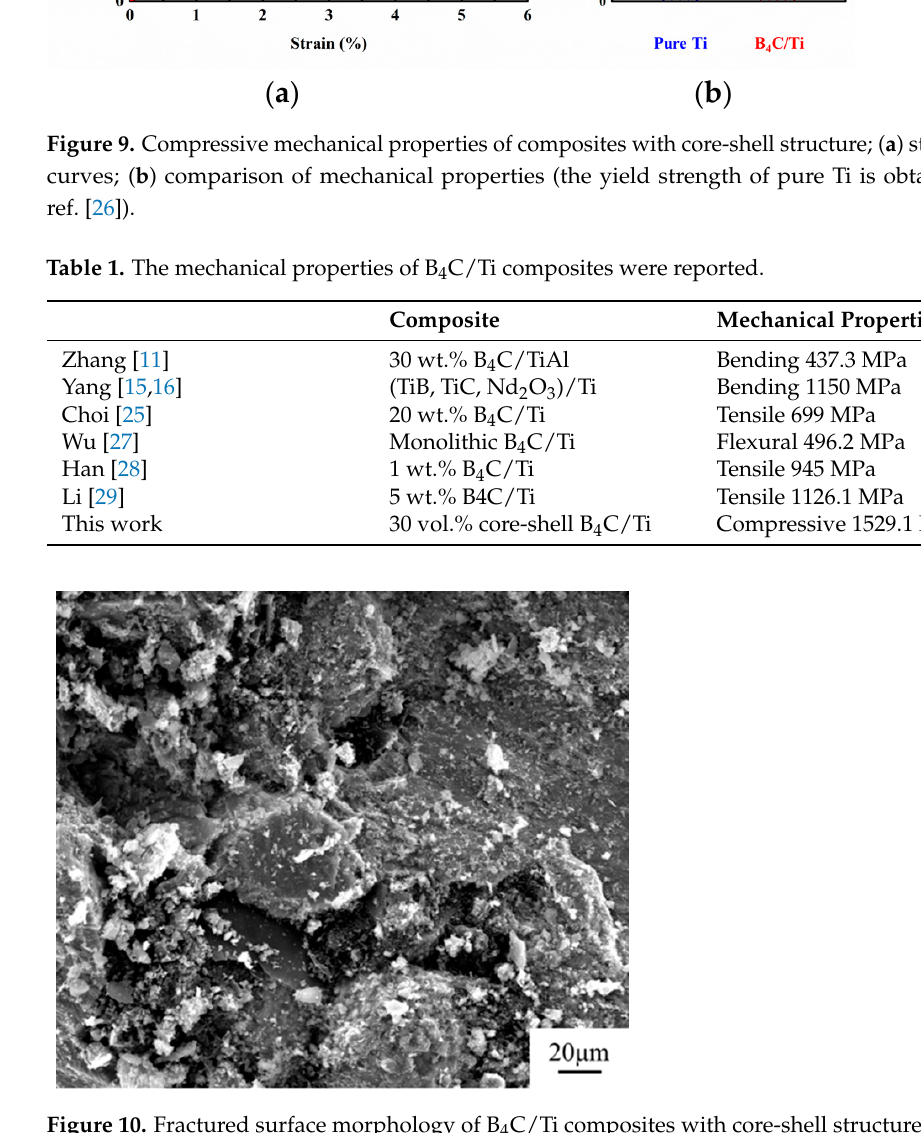
Figure 10. Fractured surface morphology of B 4 C/Ti composites with core ‐ shell structure.